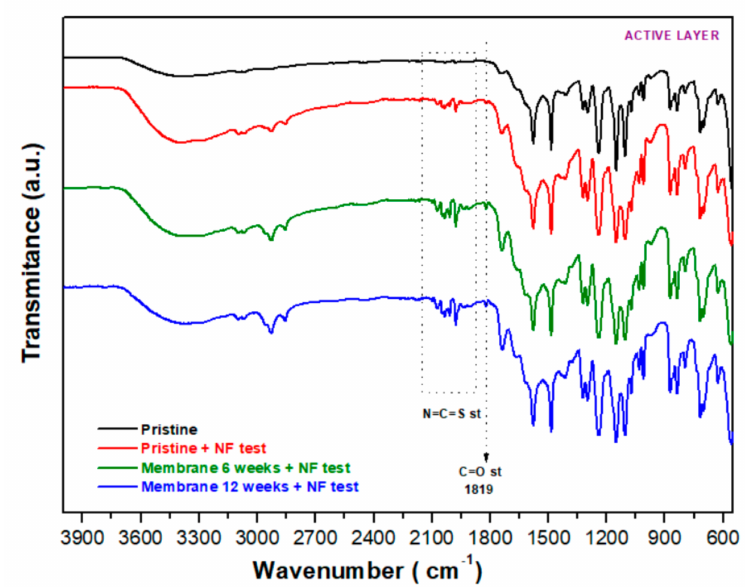
Figure 6. FT − IR spectra of the active layer for the pristine membrane before and after the NF test as well as the active layer of membranes aged for 6 and 12 weeks and after NF tests.